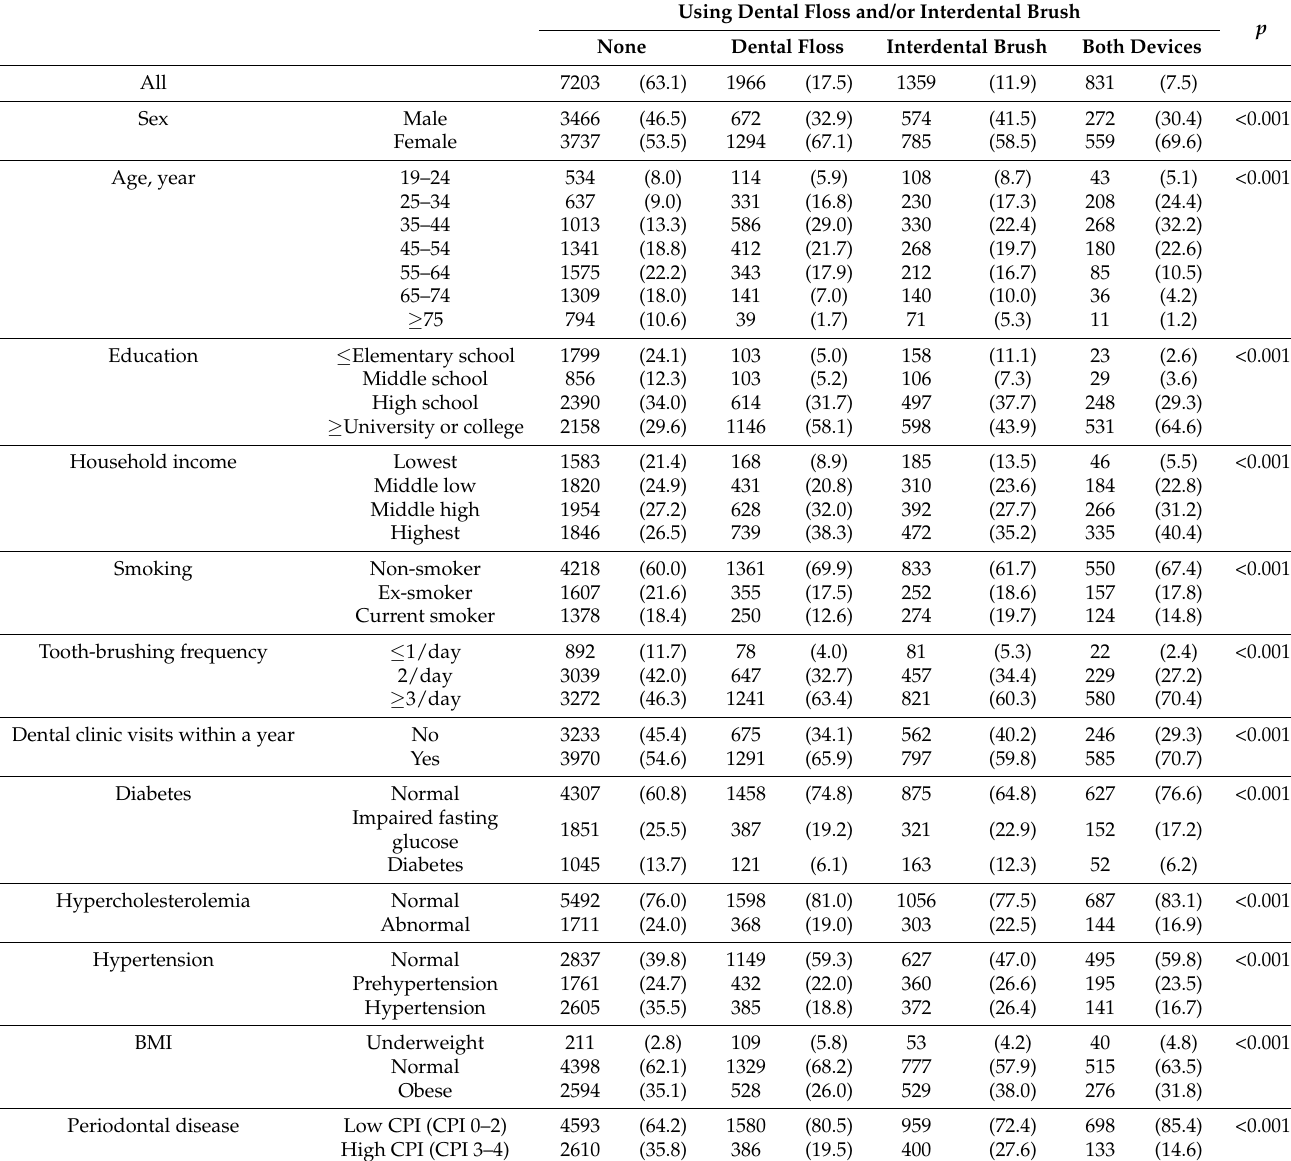
using proximal cleaning devices. Those who used all of the proximal cleaning devices were found to have a more positive tooth-brushing frequency, non-smoking, and dental visit practices than those who did not use them. In addition, the prevalence of diabetes, hypercholesterolemia, hypertension, and high CPI was significantly lower (Table 2). Table 2. Characteristics of the study population using dental floss and/or interdental brush. Using Dental Floss and/or Interdental Brush p None Dental Floss Interdental